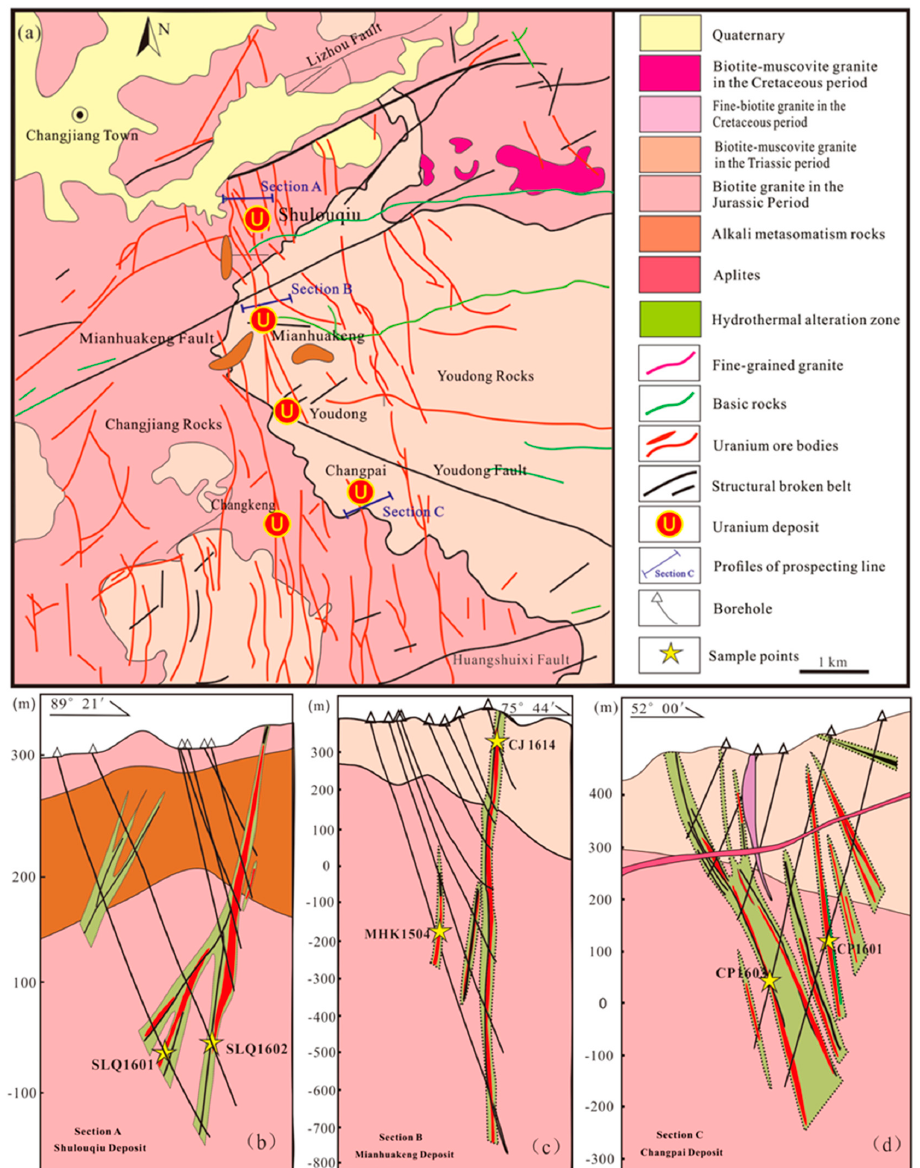
Figure 2. The MHK uranium ore field and related geological profiles [27,31]. ( a ) Geological sketch map of MHK uranium ore field. ( b ) Geological cross section of A, Shulouqiu Deposit. ( c ) Geological cross sectionof B, Mianhuakeng Deposit. ( d ) Geological cross sectionof C, Changpai Deposit.